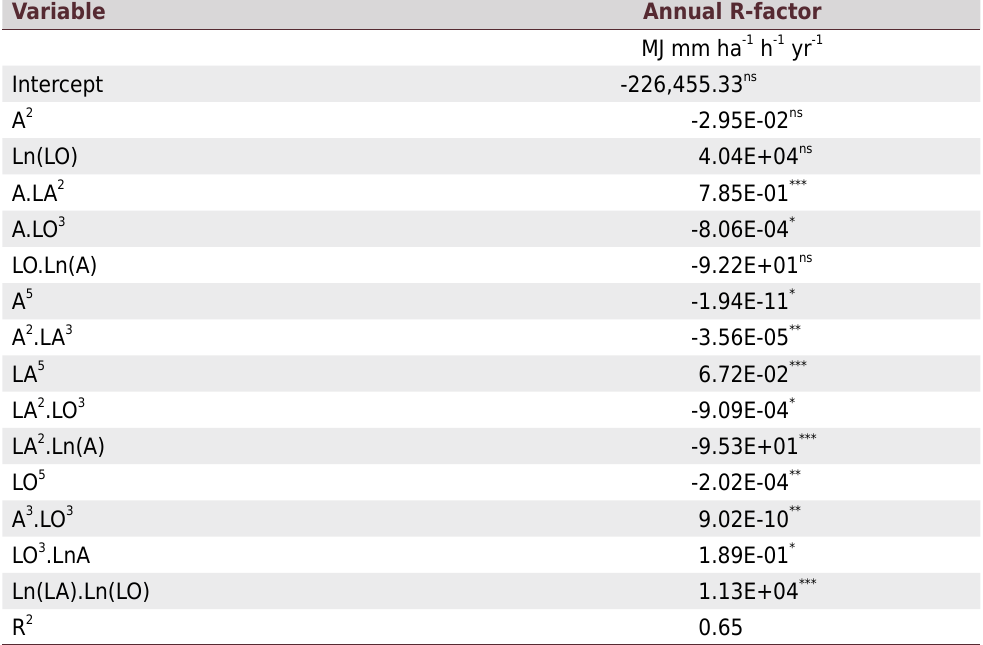
Table 4. Fitted statistical model developed for R-factor, having altitude (A), in m, longitude (LO) and latitude (LA) as explanatory variables for the state of